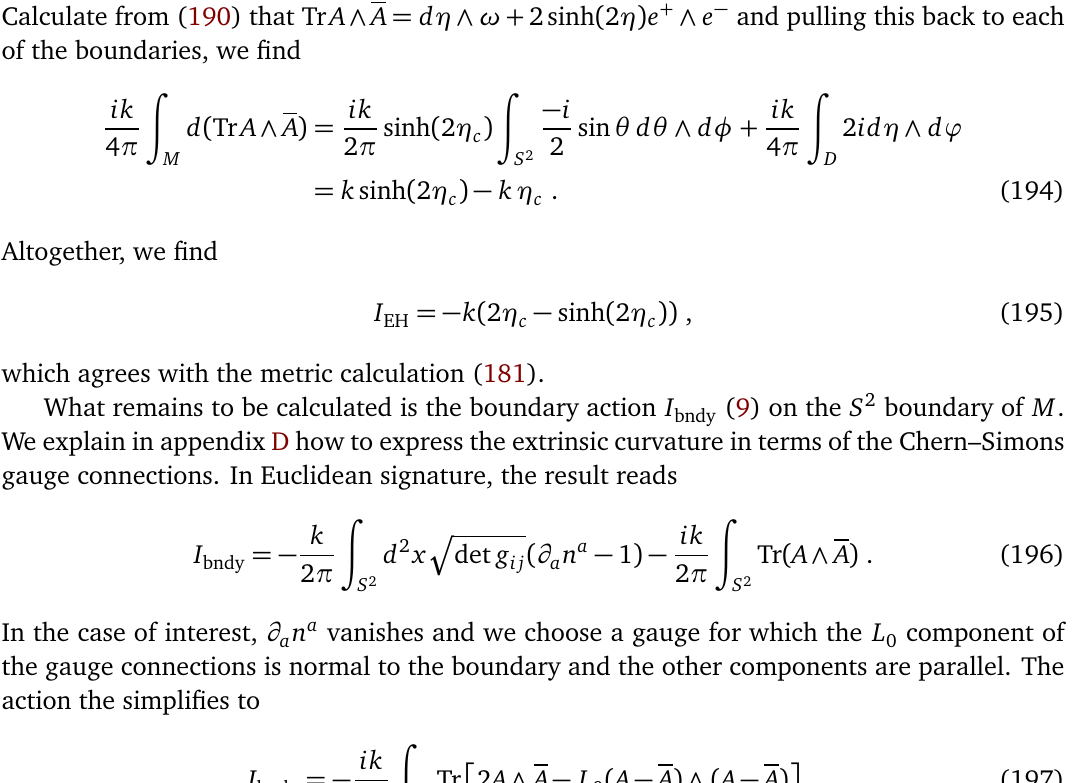
Figure 1: Global Euclidean AdS and its different components and boundaries. The 3 bulk of AdS is composed of two patches, AdS and AdS , whose boundaries at η 3 S N are the southern and a northern hemisphere S 2 and S 2 , respectively. The bulk com- S N ponents are separated by an equatorial disk D , whereas the boundary hemispheres touch at the equator E